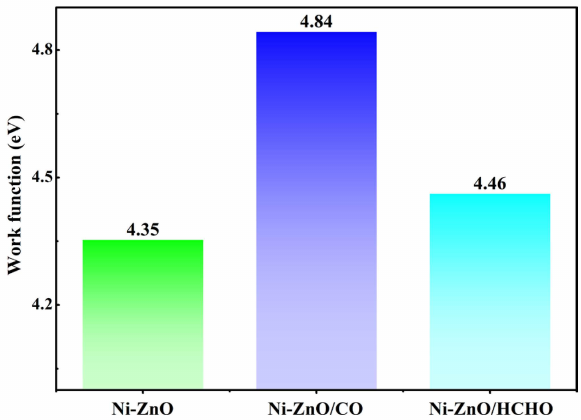
Figure 5. WF of pure Ni–ZnO monolayer and Ni–ZnO/gas